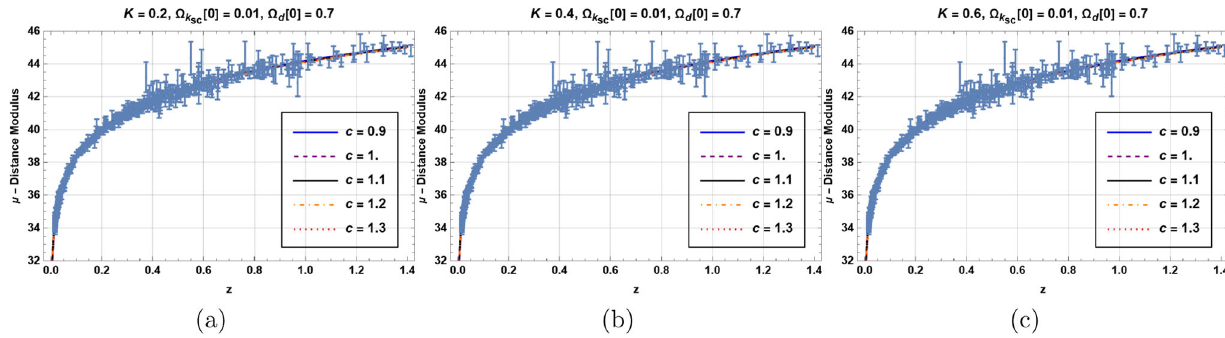
[ 0 ] = 0 . 7. Bars display the 580 Union 2.1 scores along with the (cid:2) d SNIa results from the distance modulus data set